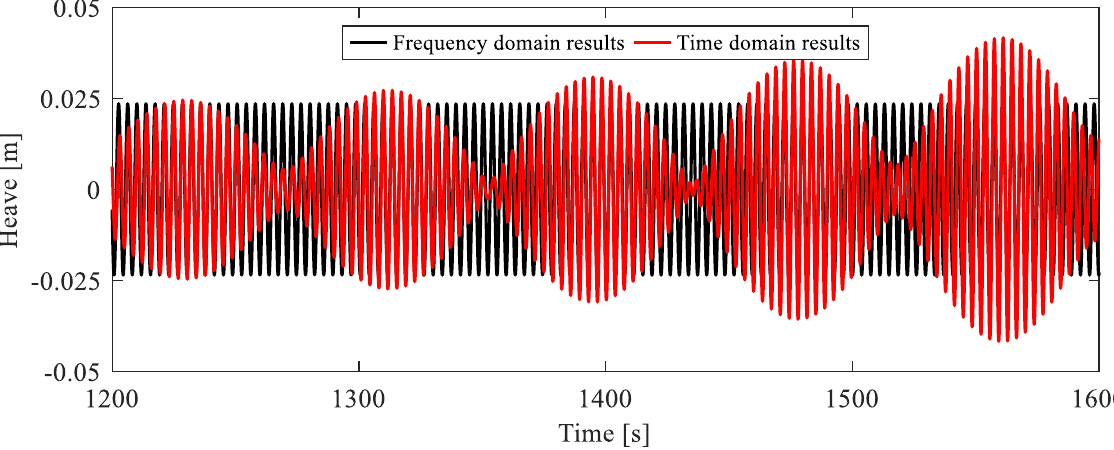
0.03 0.02 0.01 ( a ) Comparison of the heave motions by the time and frequency domain models for the artificial damping ratio of 0.05 ( b ) Comparison of the heave motions by the time and frequency domain models for the artificial damping ratio of 0.1 -0.03 -0.02 -0.01 0